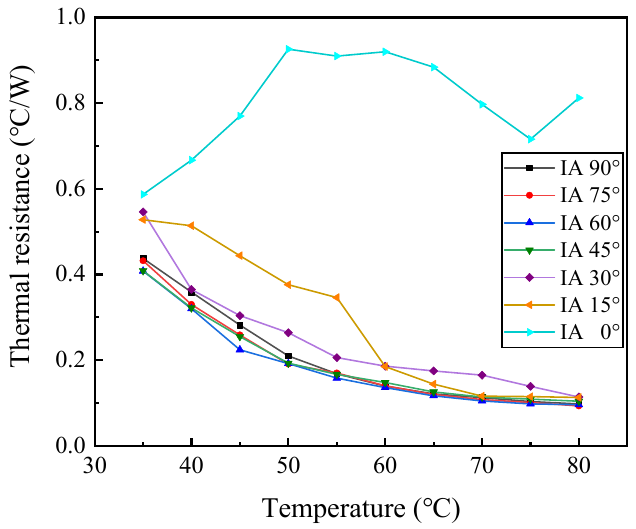
Figure 6. Thermal resistance versus temperature at different inclination angles. The CLPHP is placed vertically, the relative pressure is − 100 kPa, the filling ratio of methanol-deionized water is 40%, the average heating (Hea) temperature of the evaporation section is 80 ◦ C, which is the ideal working temperature of PEMFC. The temperature change at the center of each section of CLPHP at constant condensation (Coo) temperature is shown in Figure 7. The temperatures of the evaporation section (Eva), adiabatic section (Adi), and condensing section (Con) remain stable with small fluctuations, among which the fluctuation of the evaporation section is relatively large. At this time, the heat transfer resistance of CLPHP is 0.093 °C/W, and the heat flux is 1.59 W/cm 2 . In summary, CLPHP maintains a high relative negative pressure and the internal temperature fluctuation is small when PEMFC works at the ideal temperature, which is beneficial to the stable temperature of PEMFC and ensures its safe operation.